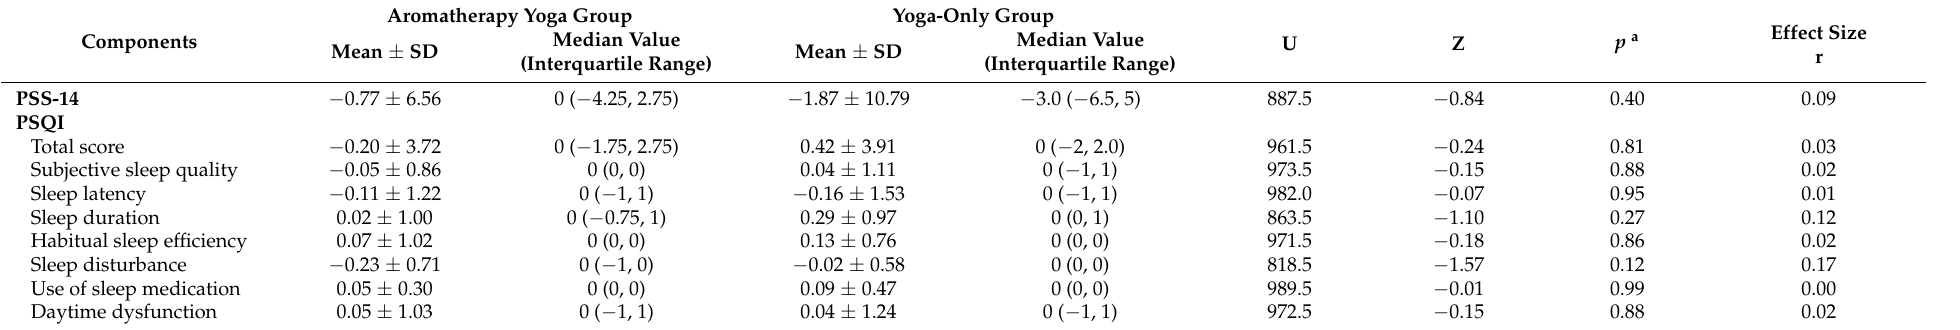
Table 3. Intergroup differences in the PSS-14 and PSQI scores in the aromatherapy yoga group and the yoga-only